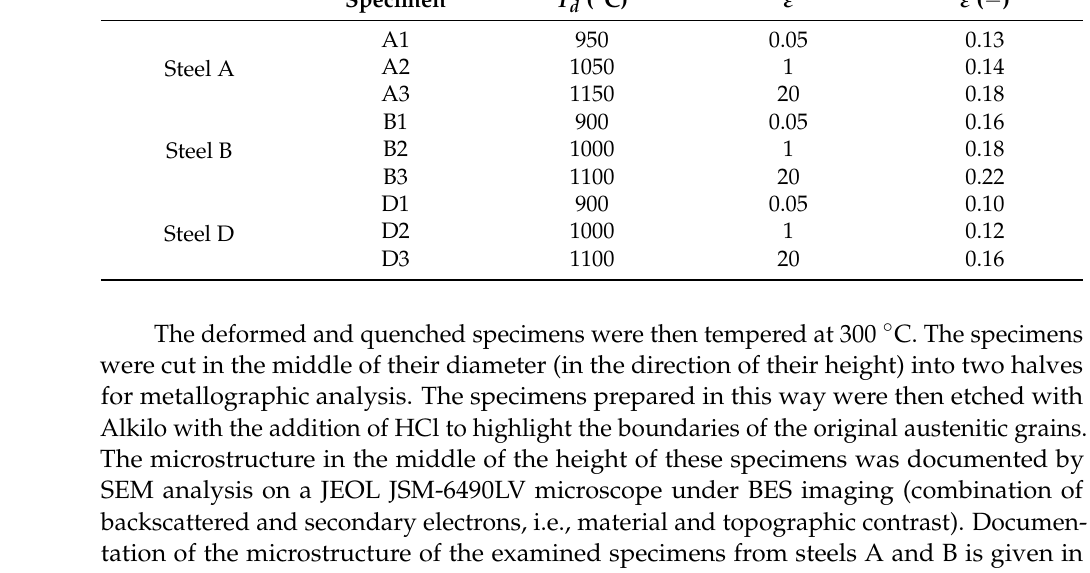
. ε = 1 s − 1 , ε = 0.14; ( c ) T d = 1150 ◦ C,